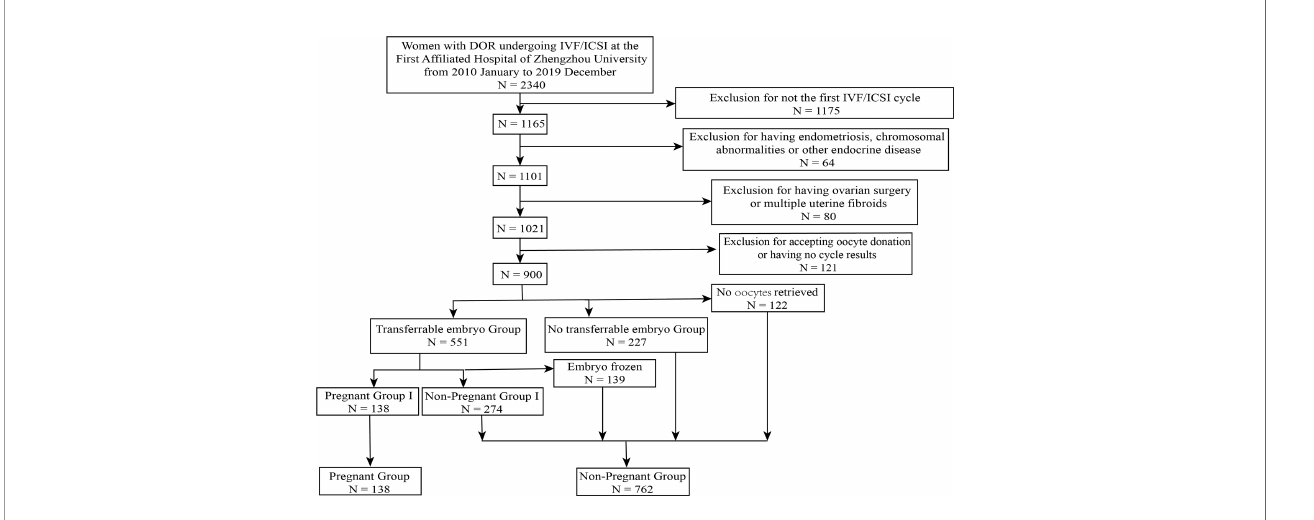
FIGURE 1 | Flow chart of patient